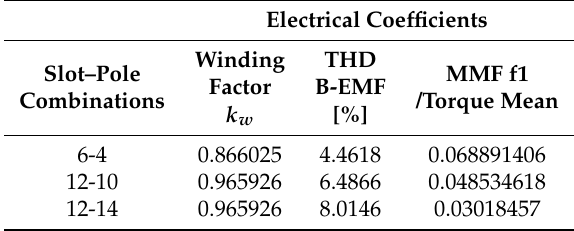
Table 9. Performance of healthy SL slot–pole combinations, Part